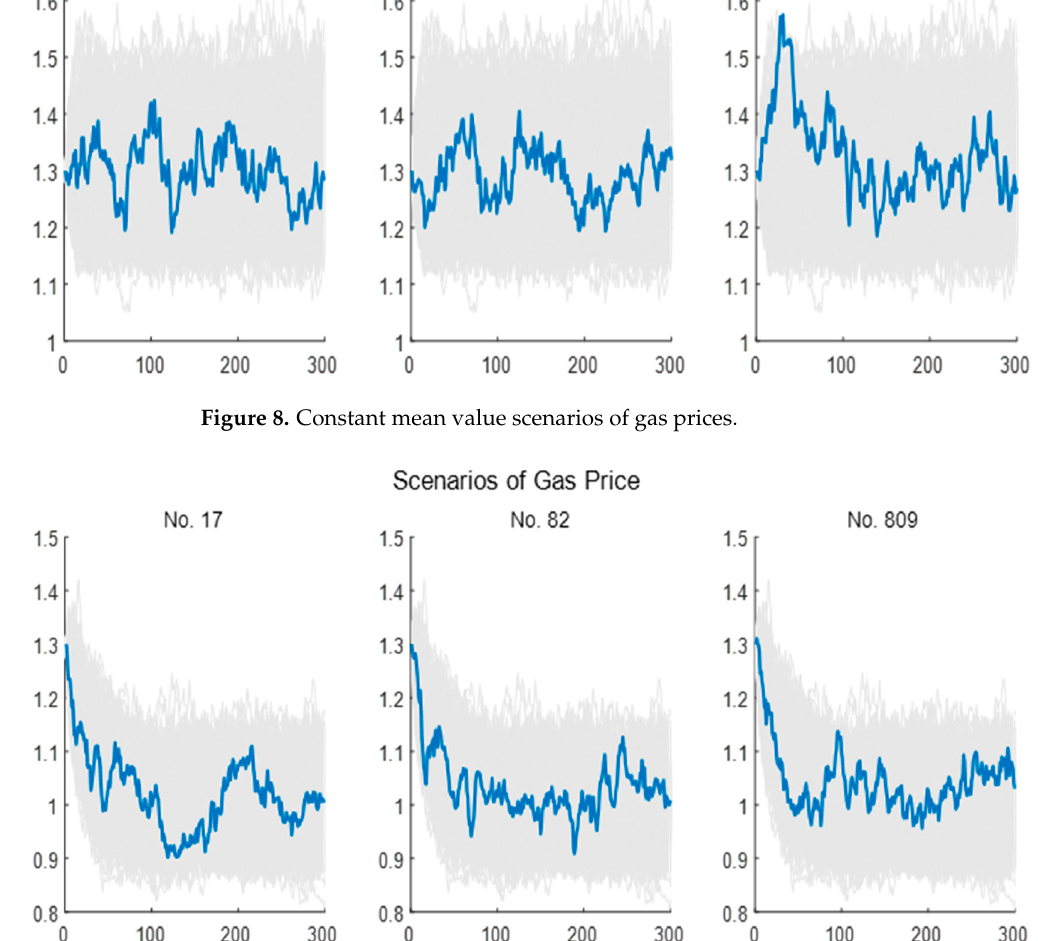
Figure 9. Mean value decline scenarios of gas prices.